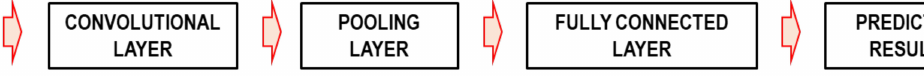
Figure 15. A general CNN